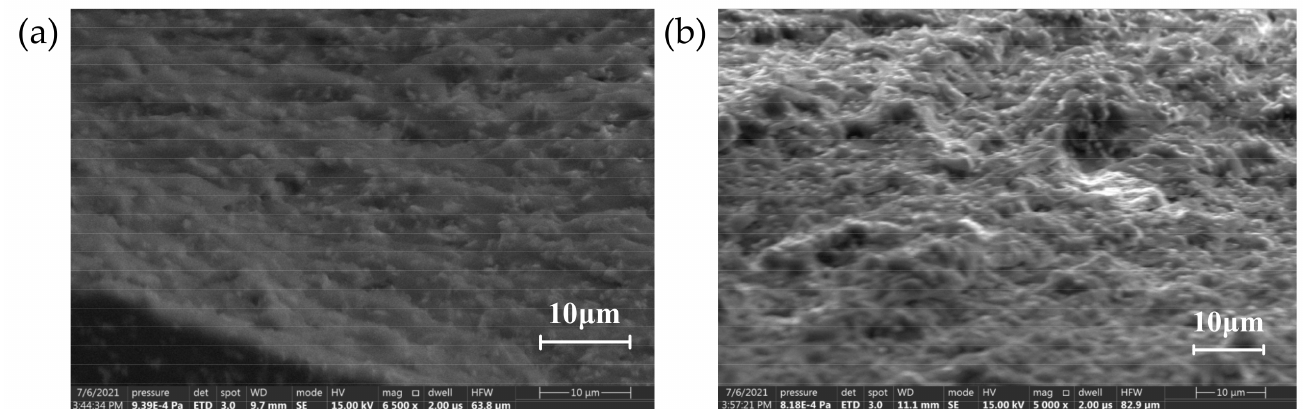
Figure 20. The cross-sectional microscopic electron microscope image of the micro-nano composite system. ( a ) 29.5% m-SiC/0.5%n-SiC/EP; ( b ) 27.5%